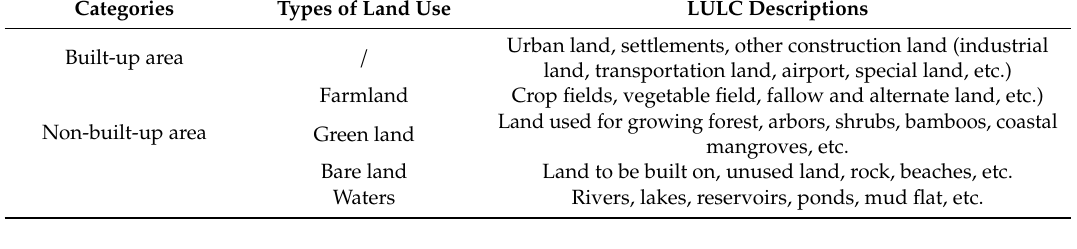
Table 3. Description of each land use type.